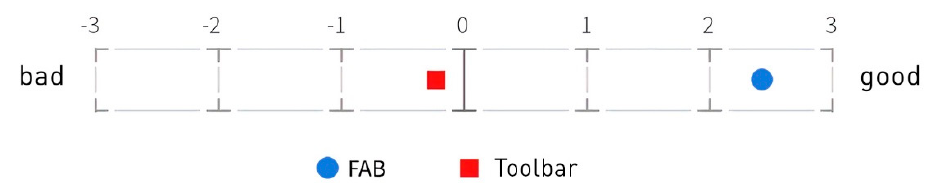
Figure 2. Average answers to the task on a scale from “bad to good” for each prototype.